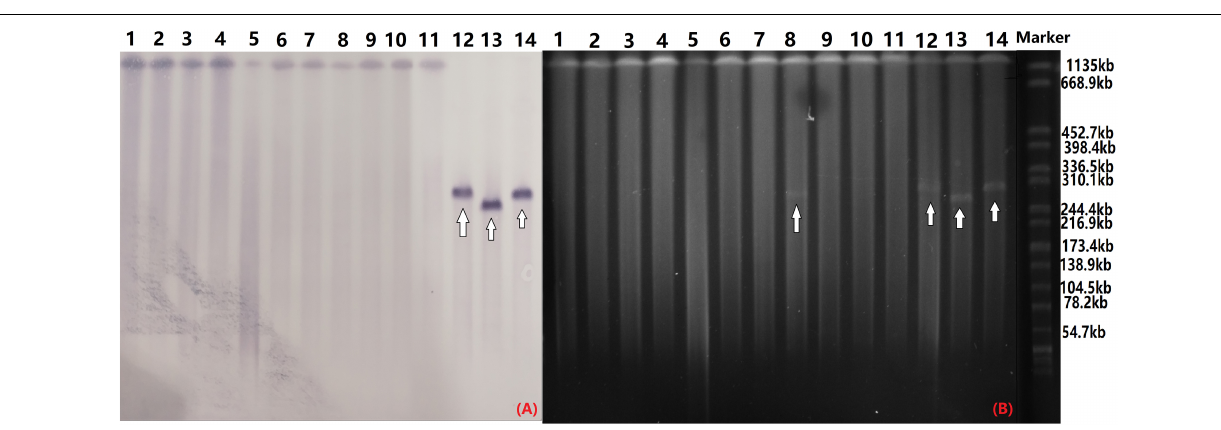
FIGURE 2 | Southern blot hybridization with the bla CTX - M - 55 probe (A) and S1-PFGE of S1 nuclease-digested genomic DNA (B) . The arrow indicates plasmids in the isolates. OYM4 (lane 1), OYM6 (lane 2), OYM8 (lane 3), OYM9 (lane 4), OYM13 (lane 5), OYZ3 (lane 6), OJM1 (lane 7), HZP3 (lane 8), LWP4 (lane 9), OYM10 (lane